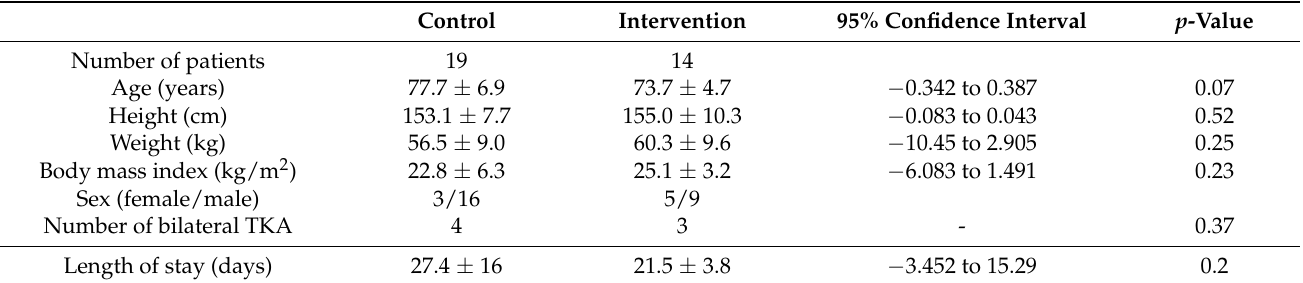
Table 1. Demographic characteristics of the